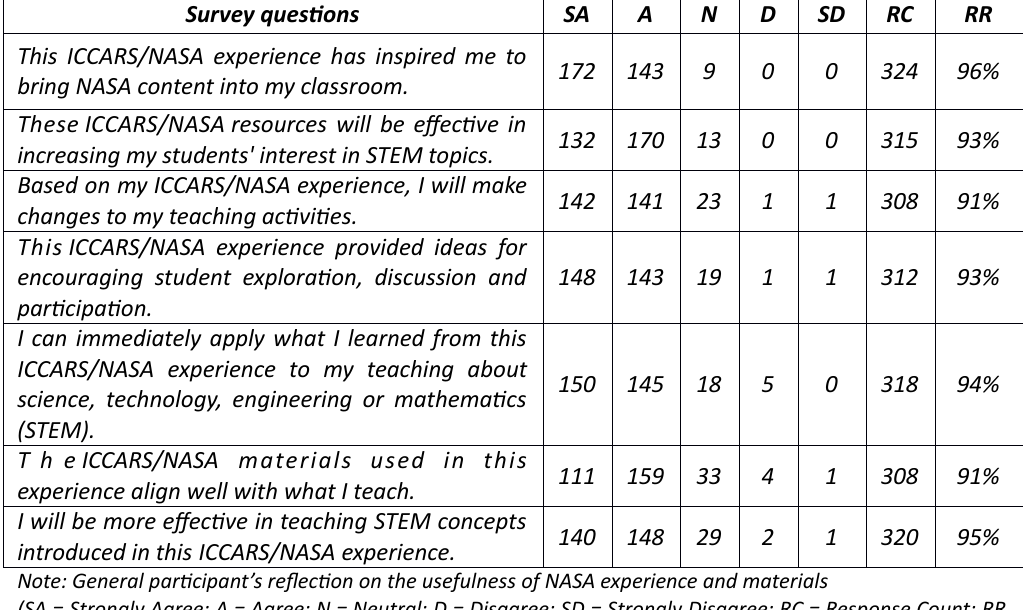
Table 2. Cumulatve results from partcipants in ICCARS actvites from the NASA Educator End of Event